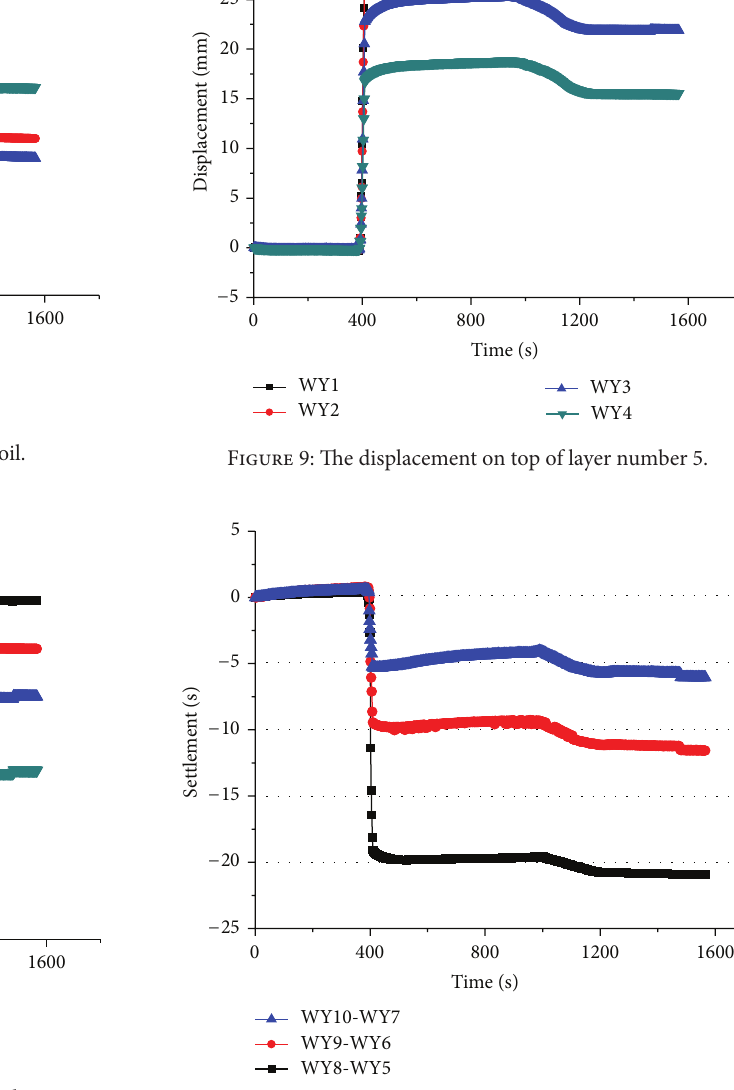
Figure 8: The displacement on top of layer number 4.